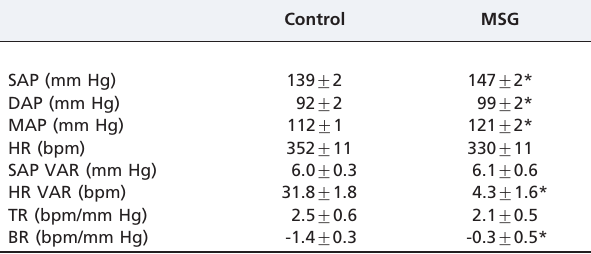
Table 1 - Hemodynamic and autonomic measurements in the control (C) and MSG-treated (MSG) groups.